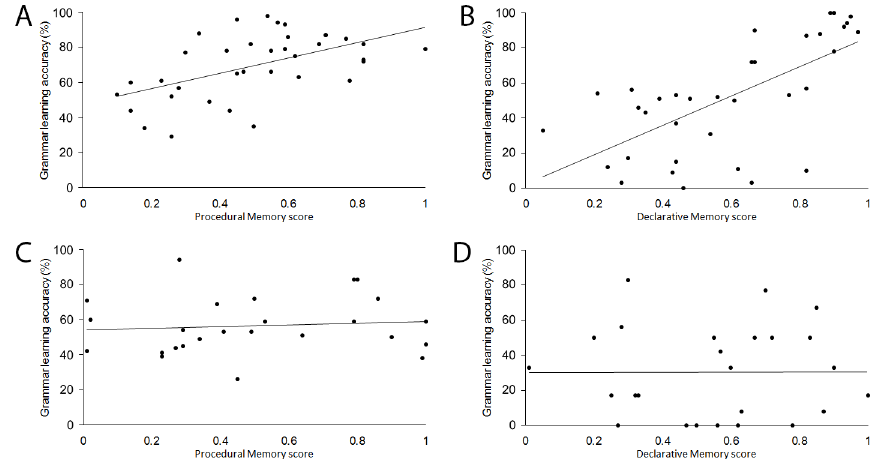
Fig 2. Scatterplots depicting correlations for baseline group between (A) procedural memory and simple grammar learning, and (B) declarative memory and complex grammar learning. For test-only group, procedural and declarative memory did not correlate with simple or complex grammar learning (C and D,